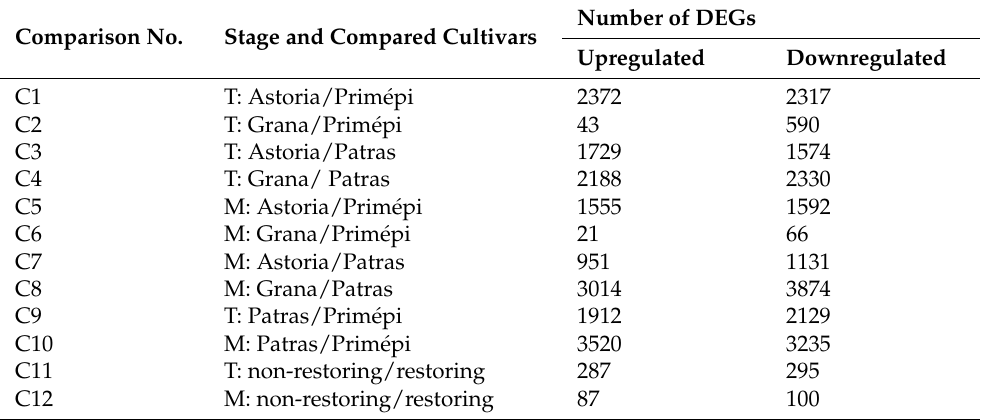
Table 1. Number of upregulated and downregulated * DEGs identified in the RNA-seq analysis. Comparison No.